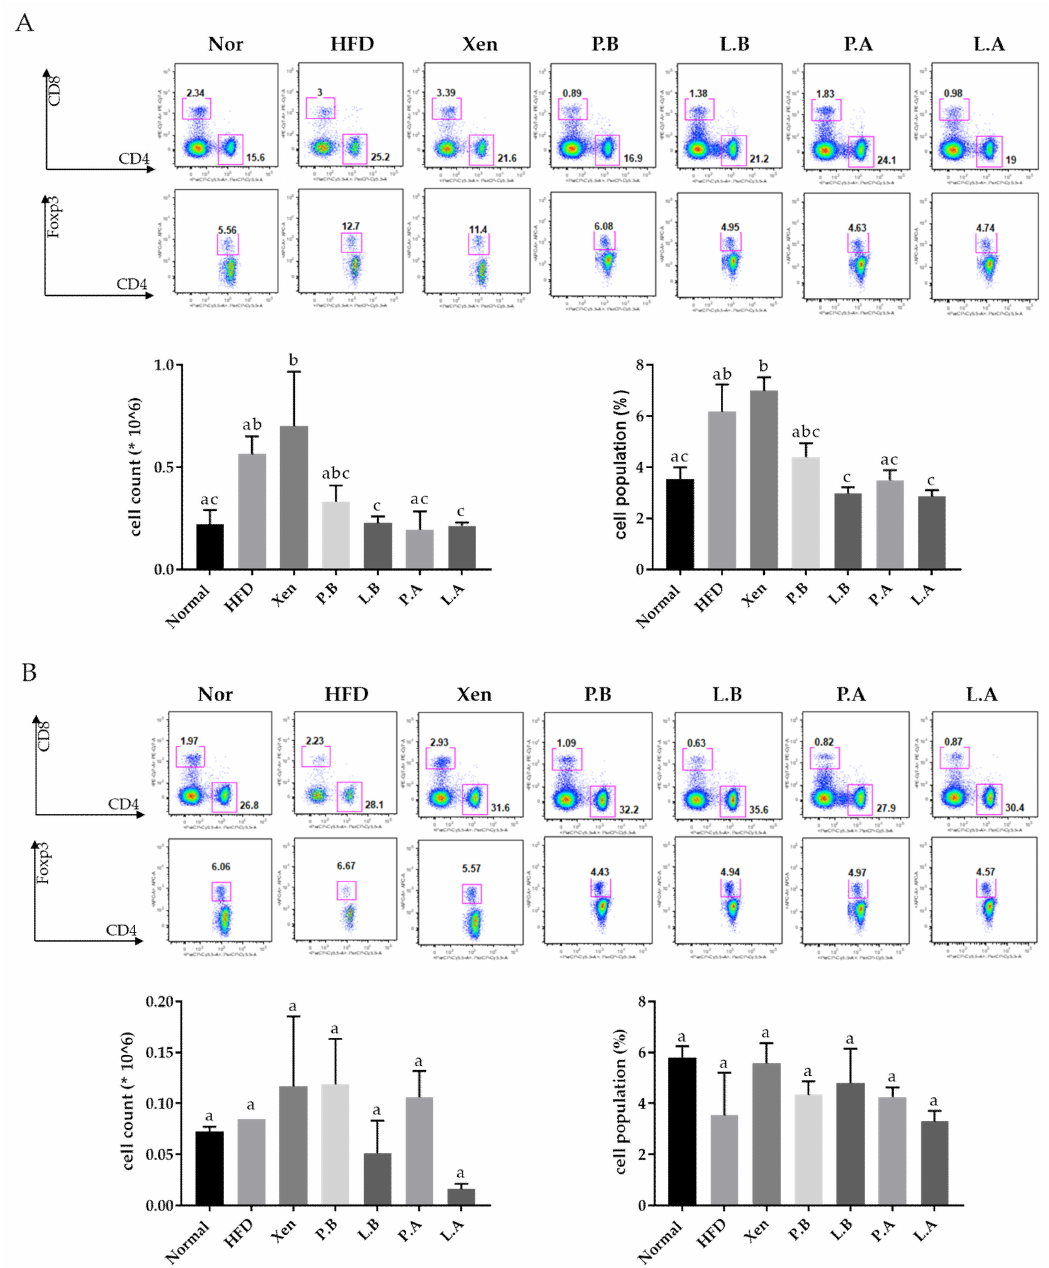
Figure 6. Treg cells numbers and population in the spleen ( A ) and MLN ( B ) tissue. The data are expressed as means ± SD; the differences were statistically evaluated using one-way ANOVA. Means without a common letter significantly differ, p < 0.05. HFD, high-fat diet; Xen, orlistat, P.B, pasteurized BAA-835; L.B, live BAA-835; P.A, pasteurized A. muciniphila ; L.A, live A. muciniphila